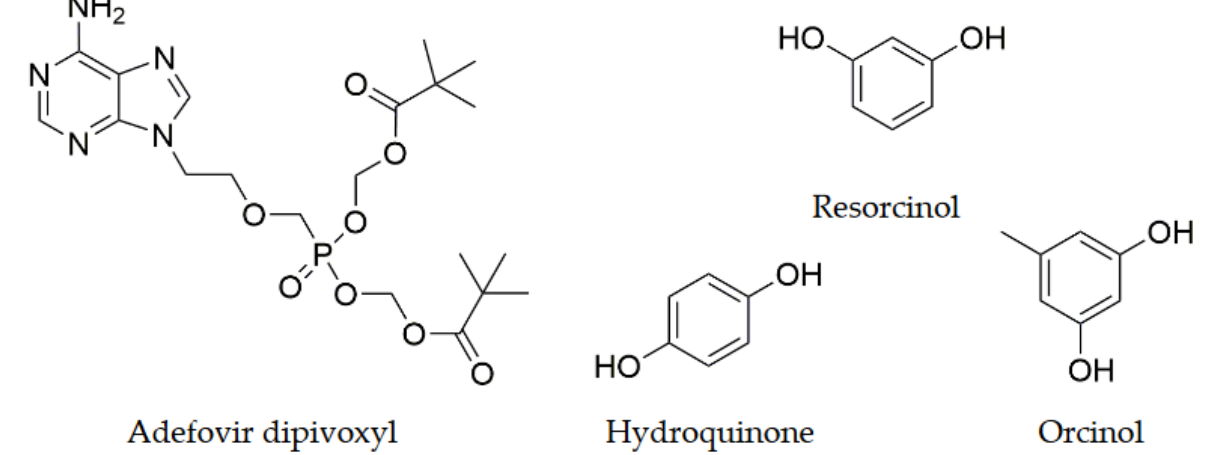
Figure 1. Molecular structures of Adefovir Dipivoxyl, and the coformers resorcinol, hydroquinone and orcinol .